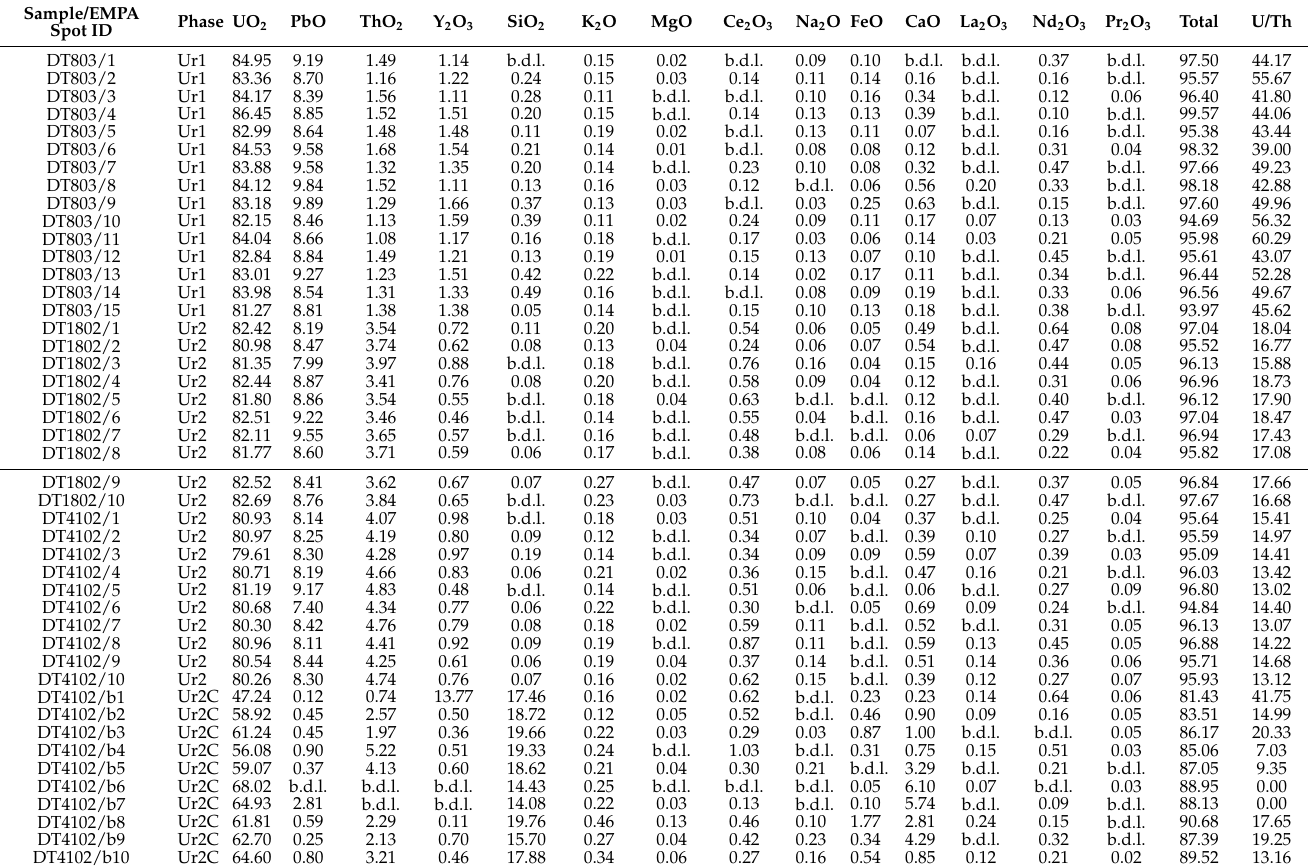
Table 1. Oxide concentrations (wt %) of uraninite and coffinite from the Datian uranium deposit. Sample/EMPA Spot ID